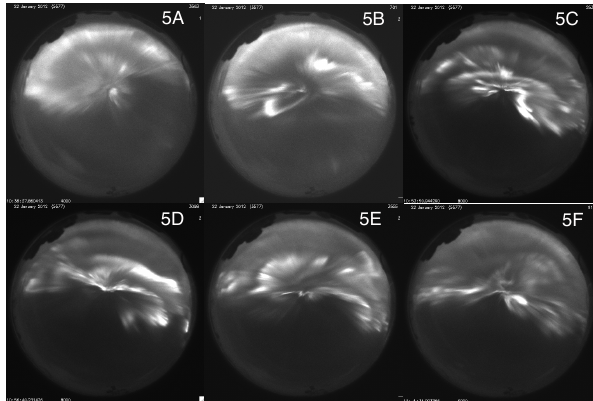
Figure 18. Event 5: all-sky images – taken on 22 January 2012 with a 557.7nm filter – showing the dynamic overall structure of the aurora at the times of the NEIALs in the PFISR data (labeled 5A–5F). North is down and east is to the right.